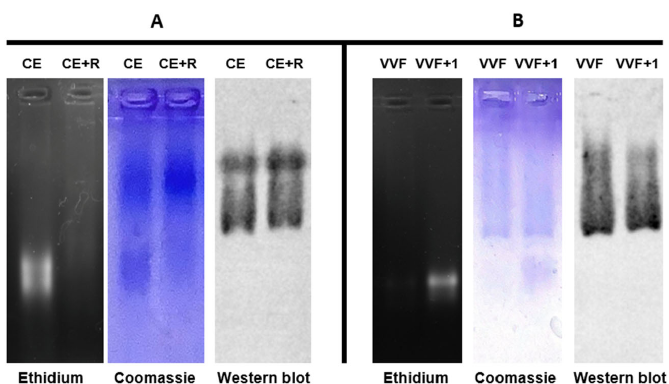
Figure 1. Electrophoretic characterization of a cell-free extract from the vault-expressing K. phaffii strain ( A ) and the purified vault ( B ). Agarose gel electrophoresis (0.7% gel) was performed on the extract before (CE) and after (CE + R) RNase treatment. Then, the gel was subjected to ethidium bromide and Coomassie staining, and Western blotting. Void volume fraction (VVF) and the following one (VVF + 1) from SEC of the RNase-treated extract was subjected to the same analytical procedures. Other details are reported in Materials and Methods (Section 4.6).